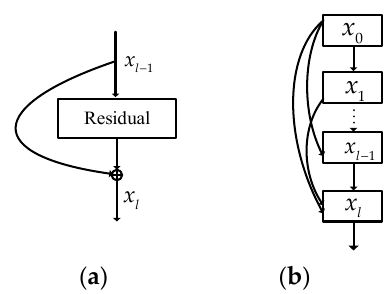
Figure 1. Schema of ( a ) residual connections module and ( b ) dense connectivity module .